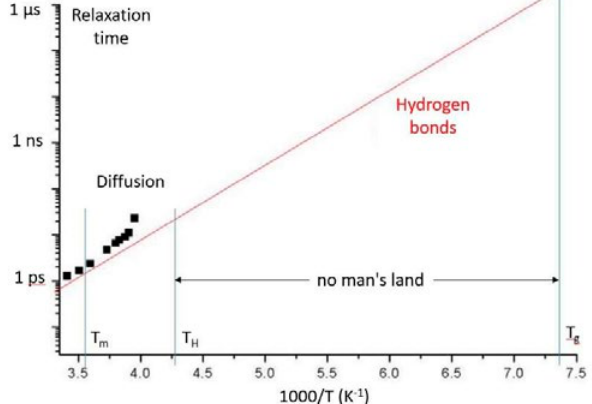
Figure 2. Schematic representation of the two times that charac- terize dynamics of liquid water. Squares represent experimental evaluations of the molecular residence time showing the anoma- lous super-Arrhenius temperature dependence. The red line is an extrapolation of the hydrogen bond lifetime evaluated at tempera- tures above -20 °C. 28 T m , T H ang T g are the melting, homogeneous nucleation and glass transition temperatures,